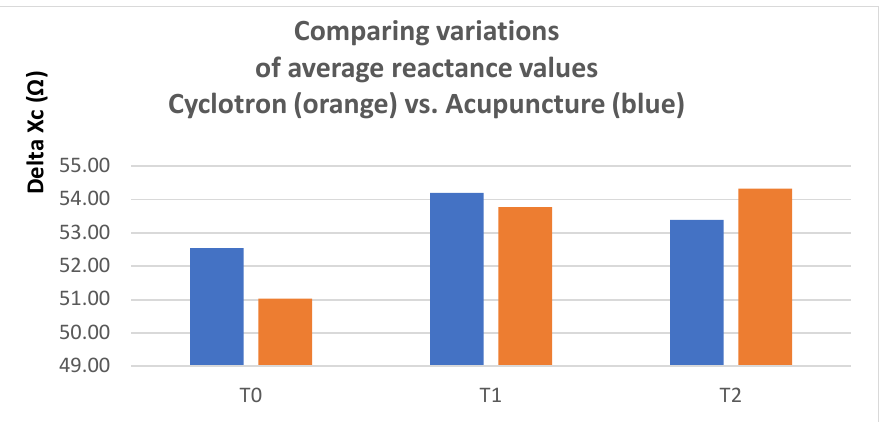
Figure 9. Average reactance increases more at T1 and less at T2, after acupuncture, and increases more after exposure to ion cyclotron emission, at the same acupuncture points.